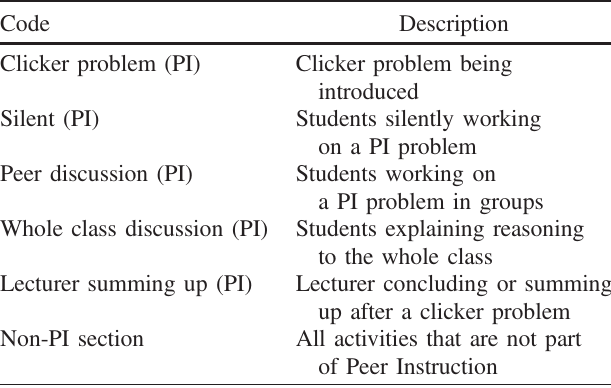
TABLE II. Codes for Peer